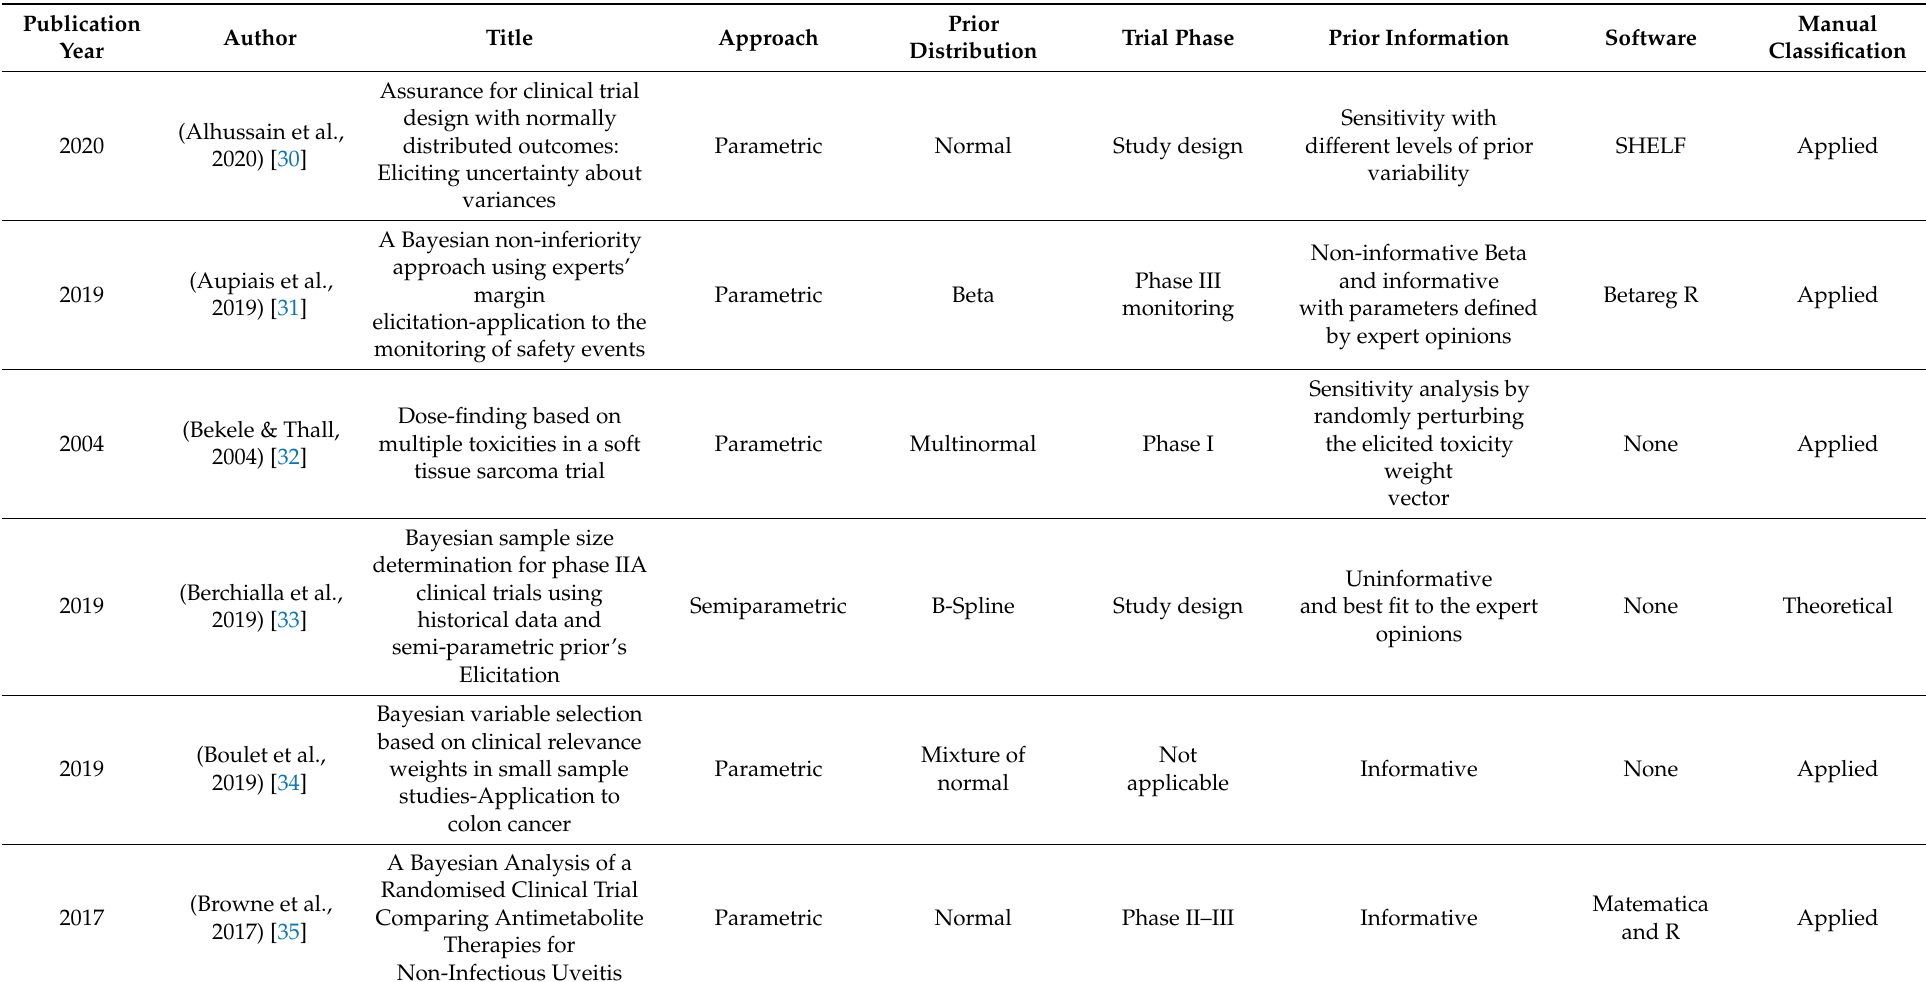
Table 1. Articles treating prior elicitation in clinical trial classified according to publication year, first author, title, main approach, the prior distribution, trial phase, prior information, software used for elicitation, manual